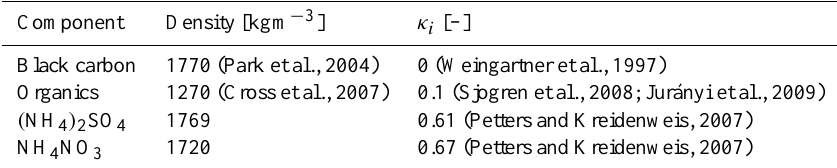
Table 2. The chemical species, their densities and their κ values that were used for our model calculations. Component Density [kgm − 3 ] κ i [–] Black carbon 1770 (Park et al., 2004) 0 (Weingartner et al., 1997) Organics 1270 (Cross et al., 2007) ( NH 4 ) 2 SO 4 1769 0.61 (Petters and Kreidenweis, 2007) NH 4 NO 3 1720 0.67 (Petters and Kreidenweis,